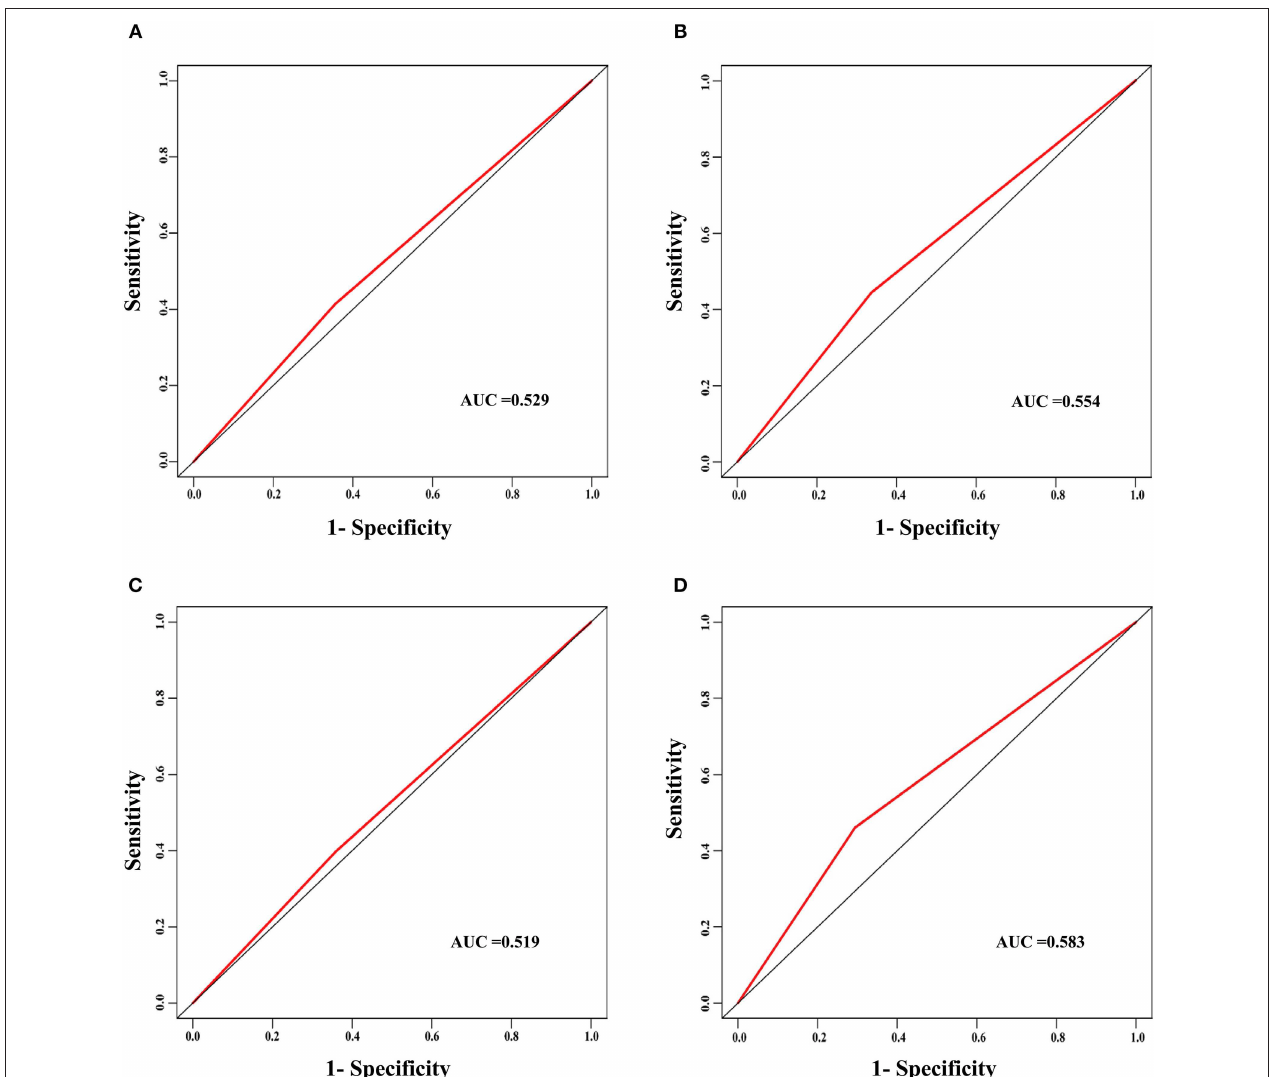
FIGURE 4 | The ROC curves of the TNM stage for the survival prediction of early hepatocellular carcinoma. (A) For predicting 3-year survival in the training group. (B) For predicting 3-year survival in the validation group. (C) For predicting 5-year survival in the training group. (D) For predicting 5-year survival in the validation group. AUC, area under the receiver operating characteristic